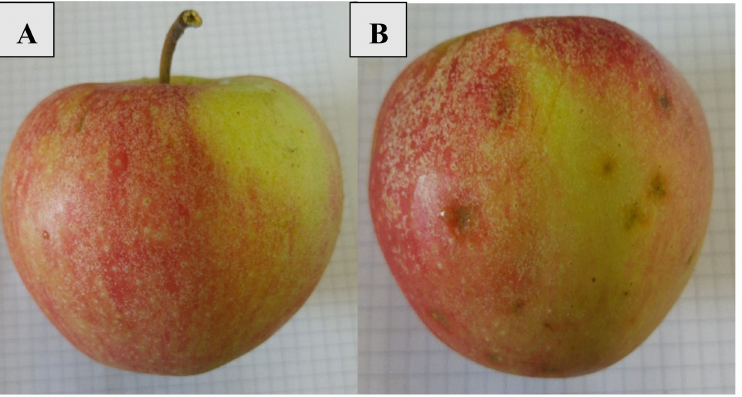
Figure 1. Uninjured apple ( A ) and brown marmorated stink bug-injured apple ( B